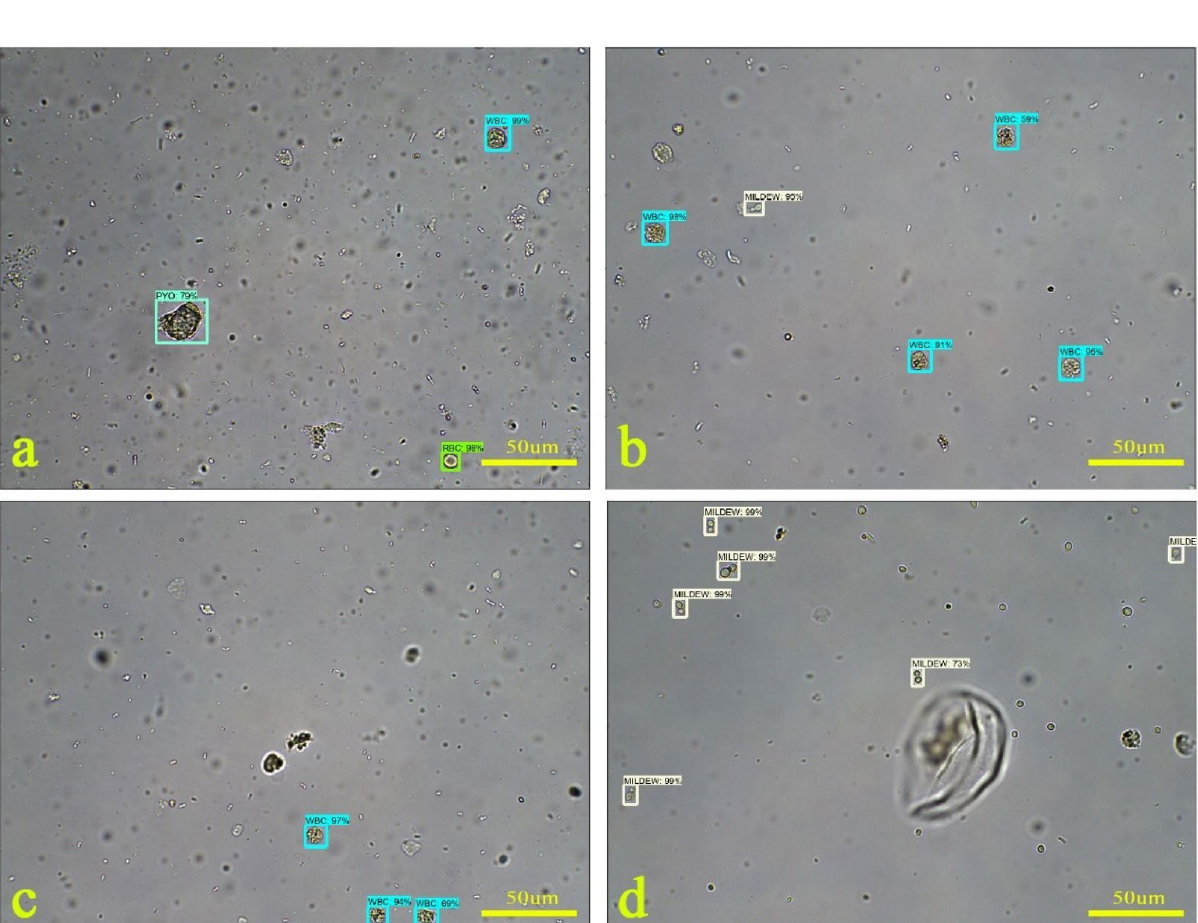
Figure 5. Curated examples of this model on our dataset. A score threshold of 0.6 is used for display. ( a ) PYO, WBC and RBC; ( b ) WBC, Mid, ( c ) WBC, ( d )